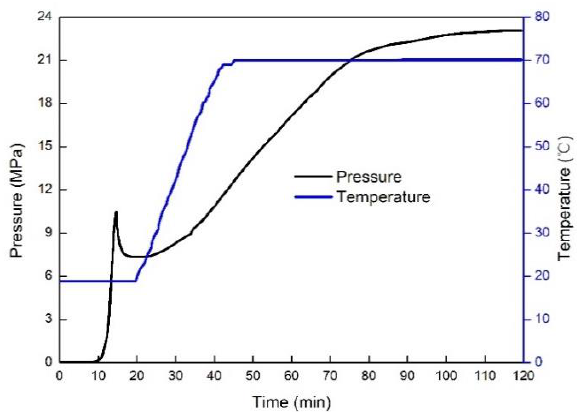
Figure 11. The curve of exothermic internal temperature and pressure during hydration of graphene–foam–cement slurry.